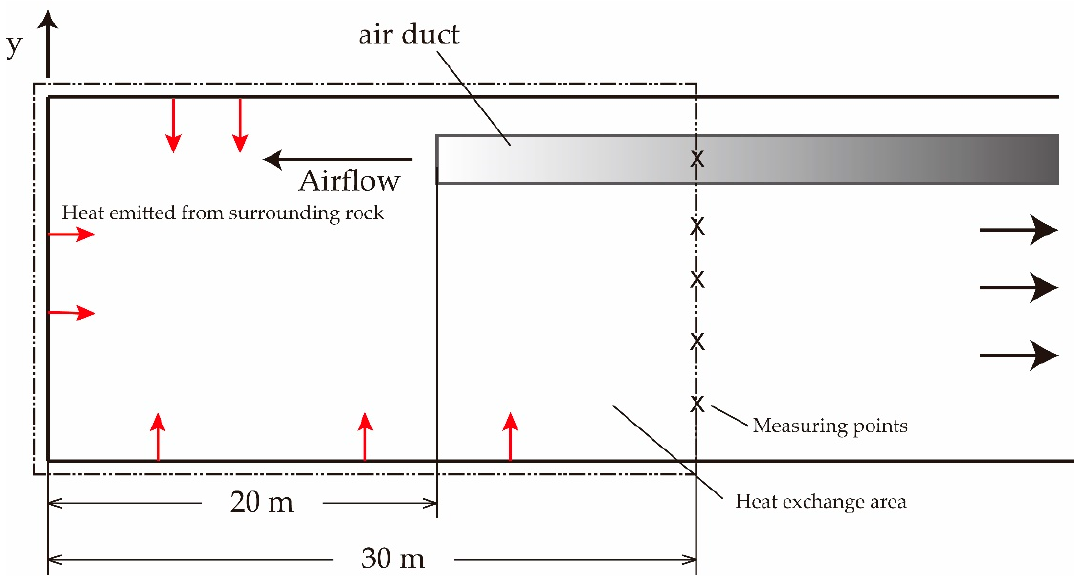
Figure 2. Side view of the blind heading, the measuring points and the heat exchange area.